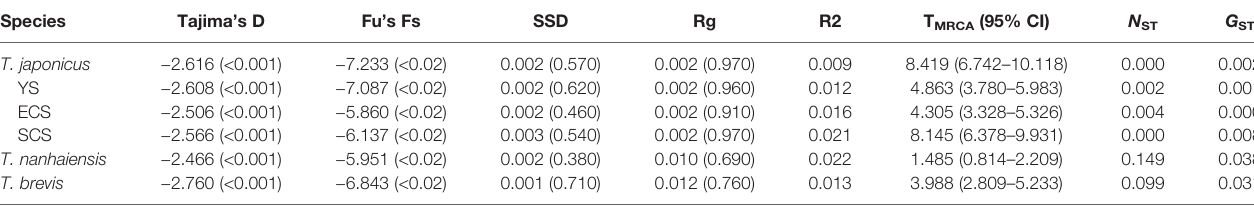
TABLE 3 | Results of dynamic tests and molecular clock analyses for T. japonicus , T. nanhaiensis and T. brevis .